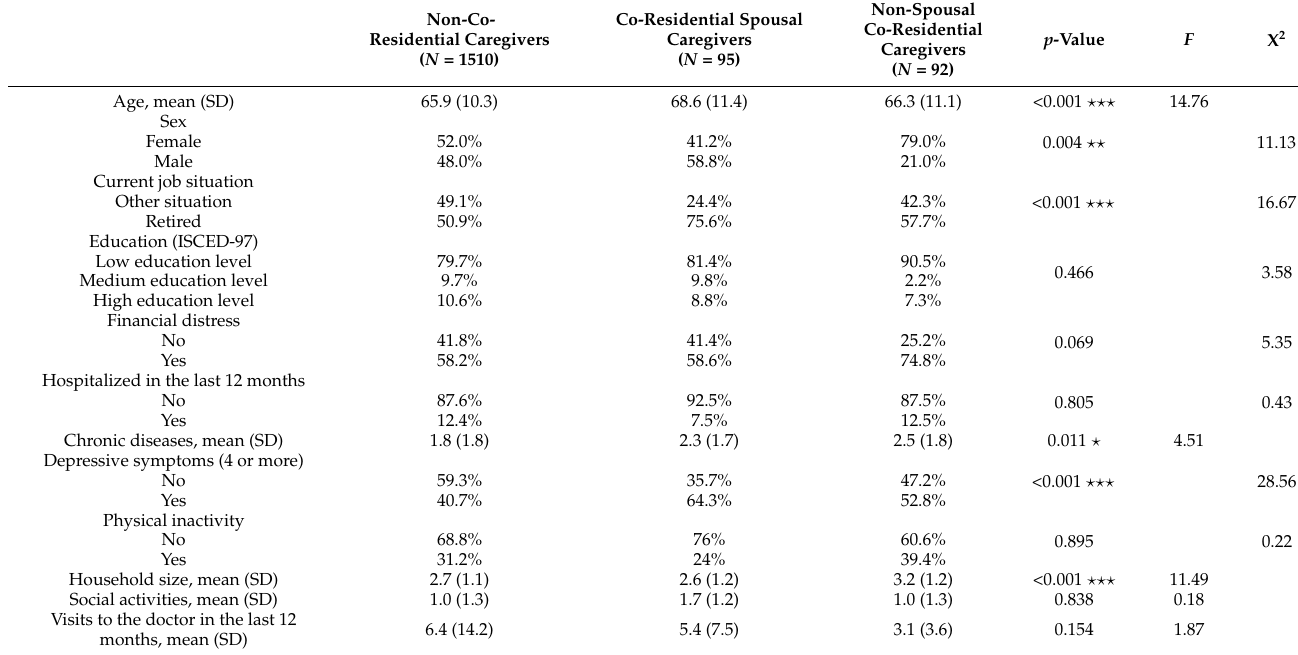
Table 1. Descriptive statistics of Portuguese aged 50 plus at baseline (wave 4), according to caregiver status. Non-Co- Residential